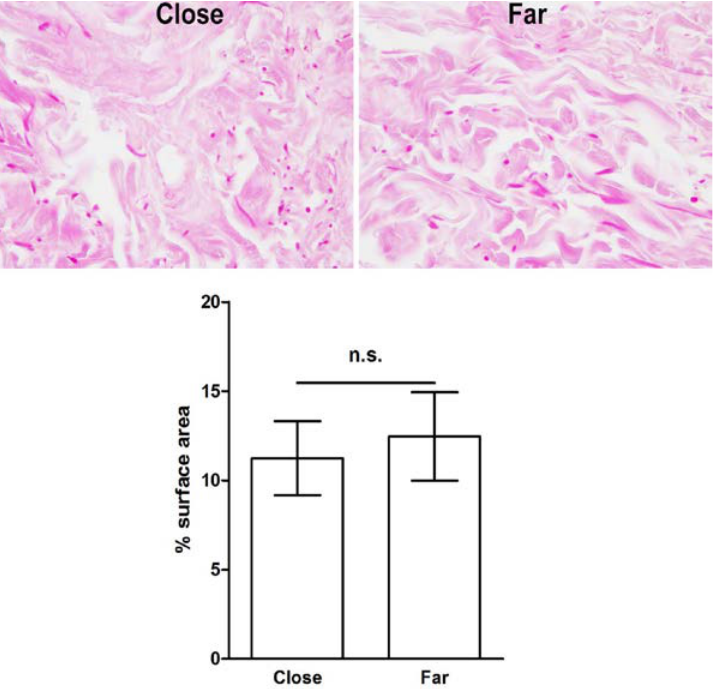
Figure 5. Light microscopic appearance and morphometry of elastic fibers in the reticular dermis from skin areas located close to and far from (3–5 mm) the surgical wound. No substantial differences can be seen or measured. PAF staining; bars = 100 µm; values are mean ± s.e.m., n = 4, n.s. not significant.